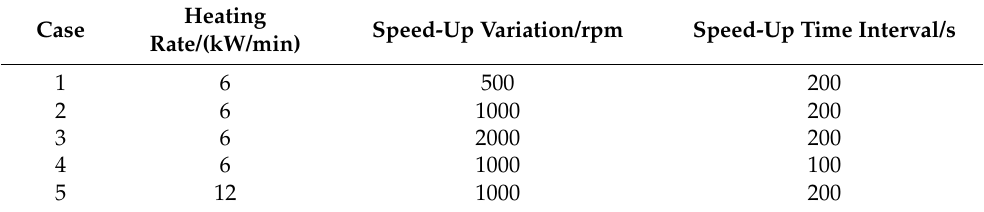
Table 8. Parameters of different cases in phase